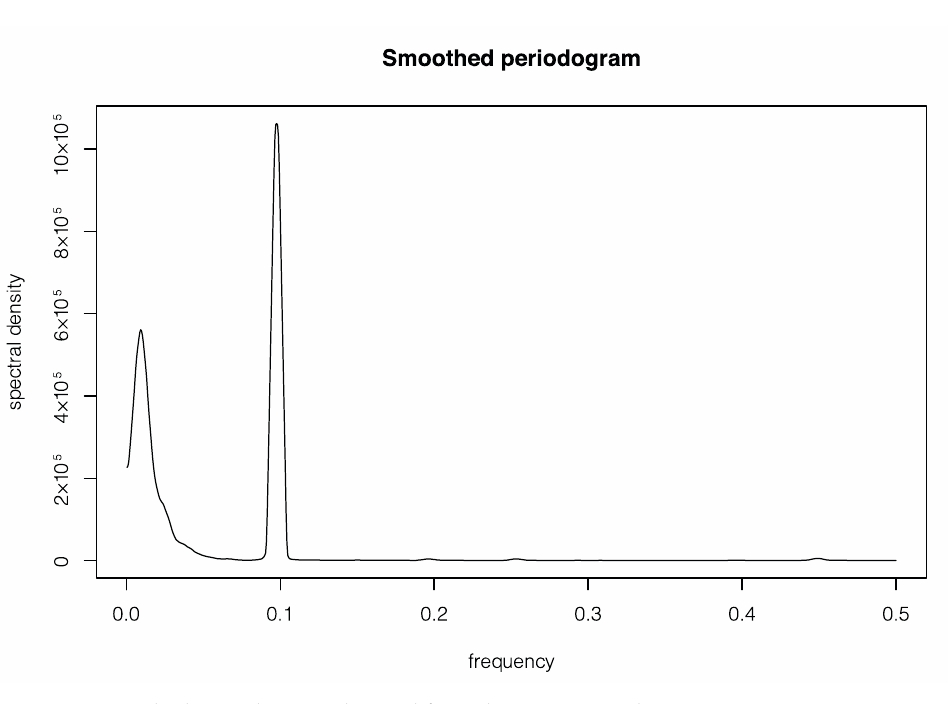
Figure 7. Smoothed periodogram obtained from the time series shown in Figure 3.